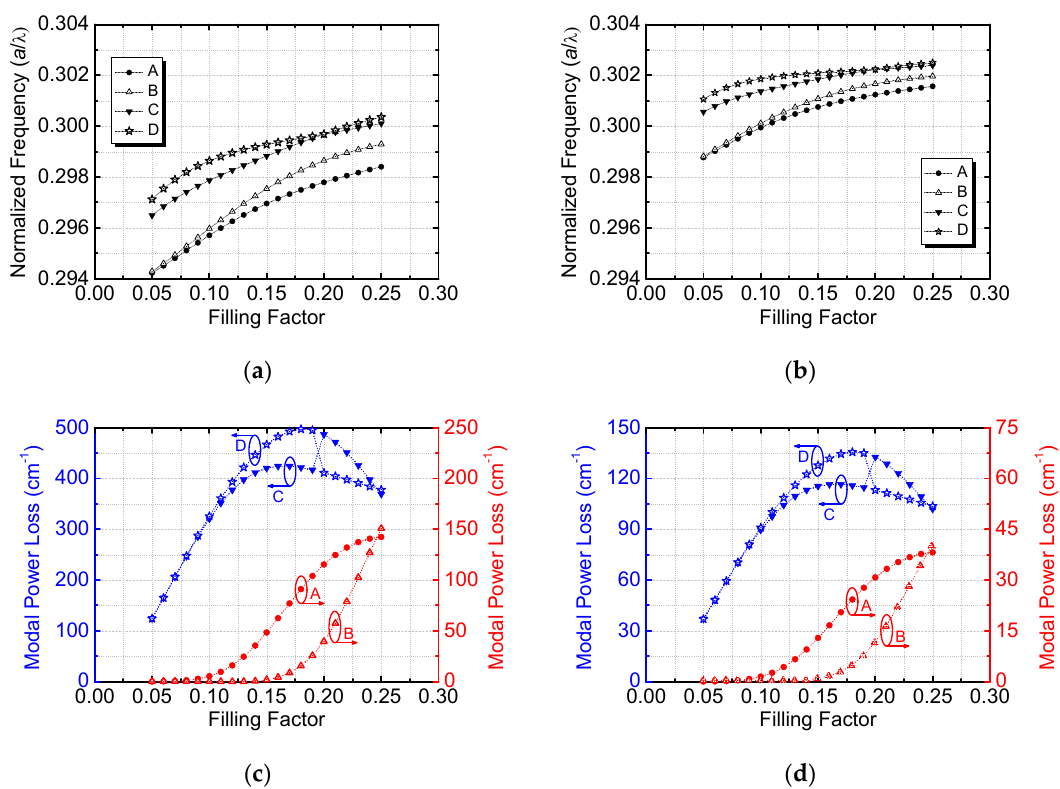
Figure 5. Infinite cavity with RIT design: the normalized frequencies of four band-edge modes versus filling factor for ( a ) air-hole and ( b ) air-pillar PC-SELs; the modal power losses of four band-edge modes versus filling factor for ( c ) air-hole and (d ) air-pillar PC-SELs.